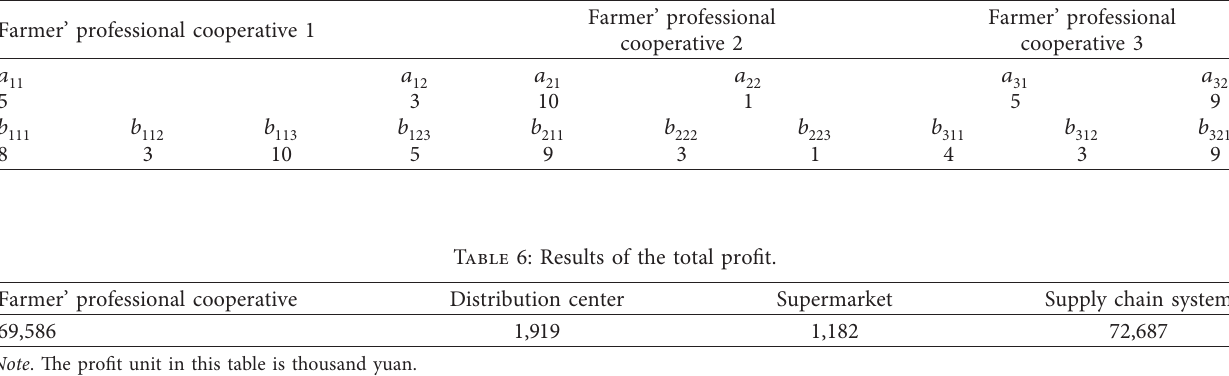
Figure 2: Fitness value of the genetic algorithm. Table 5: The best replenishment strategy.